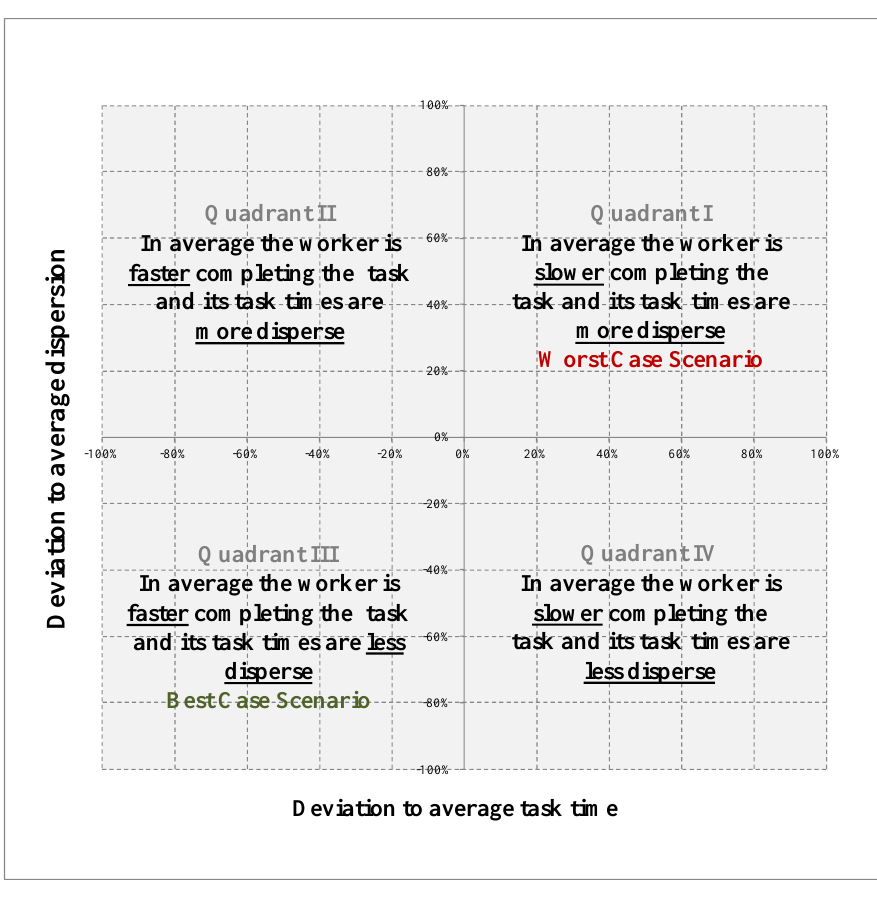
Figure 1. Workers performances graphic representation (adapted from Folgado et al., 2013; Folgado et al., 2015)